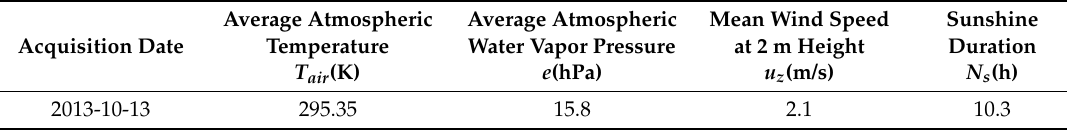
Table 5. Meteorological parameters required for calculating average atmospheric water vapor